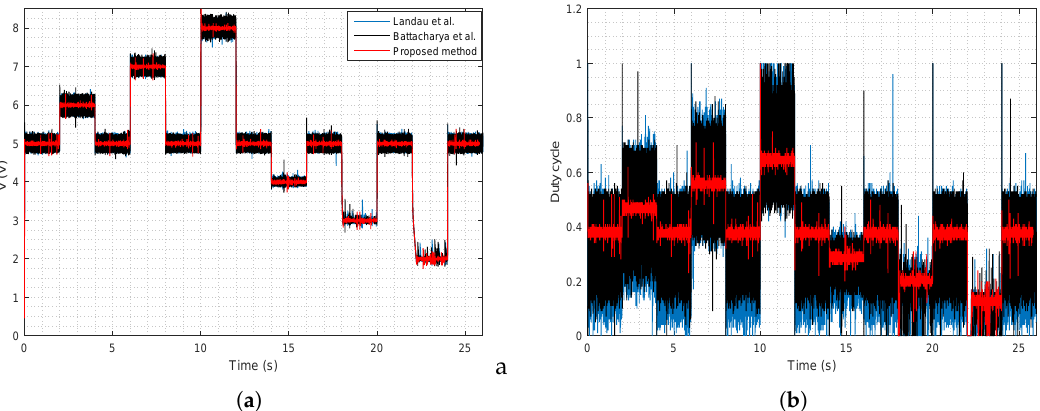
Figure 9. Experimental results of the voltage setpoint variation. ( a ) Voltage variation; ( b ) Duty cycle.